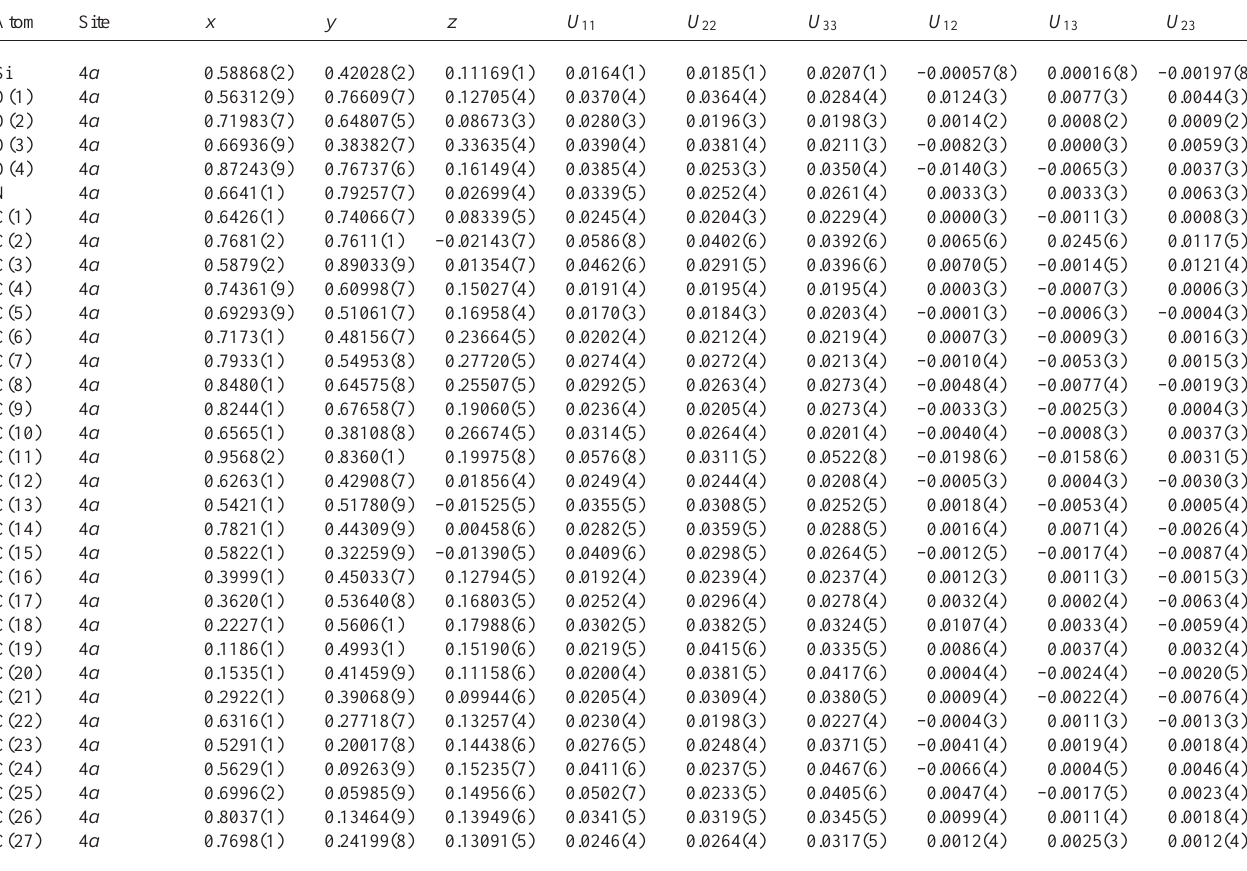
Table 3. Atomic coordinates and displacement parameters (in Å 2 )